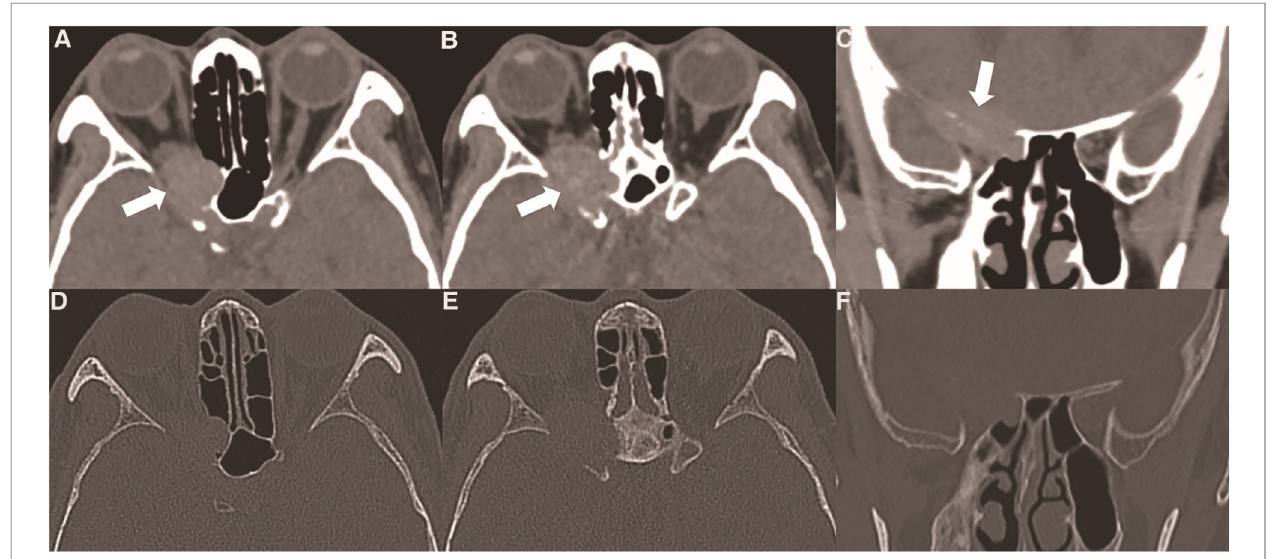
FIGURE 1 | ( A , B ) orbital CT showed that the oncocytic carcinoma affects intracranial structures through the supraorbital fi ssure, accompanied by bone destruction (thick white arrow). ( C ) Oncocytic carcinoma destroyed the skull base bone and involved the dural structure (thick white arrow). ( D, E, F ) Orbital CT bone window showed the bone of the skull base and the outer orbital wall were absorbed or destroyed by the